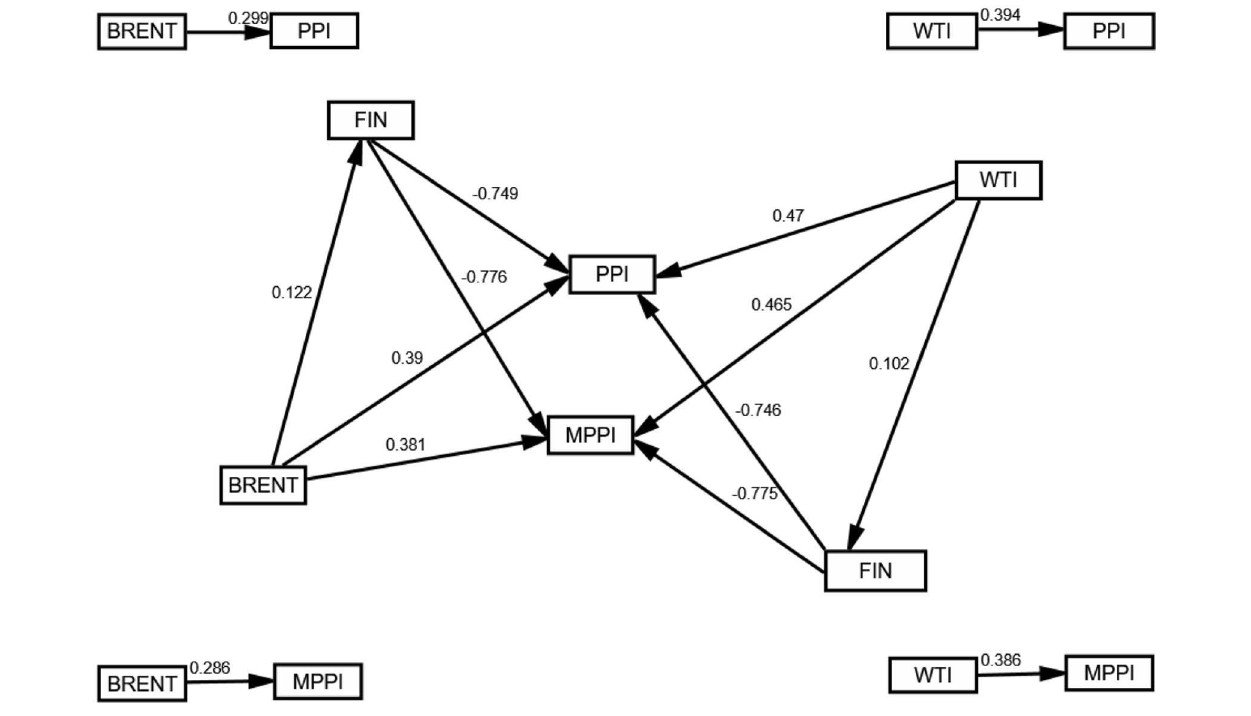
Frontiers in Energy Research |